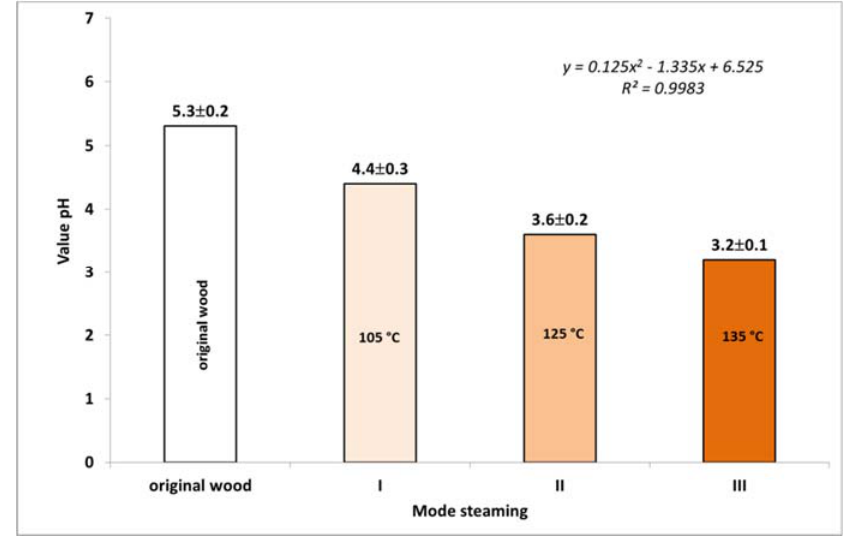
Figure 4. Change in the pH value according to steaming mode.